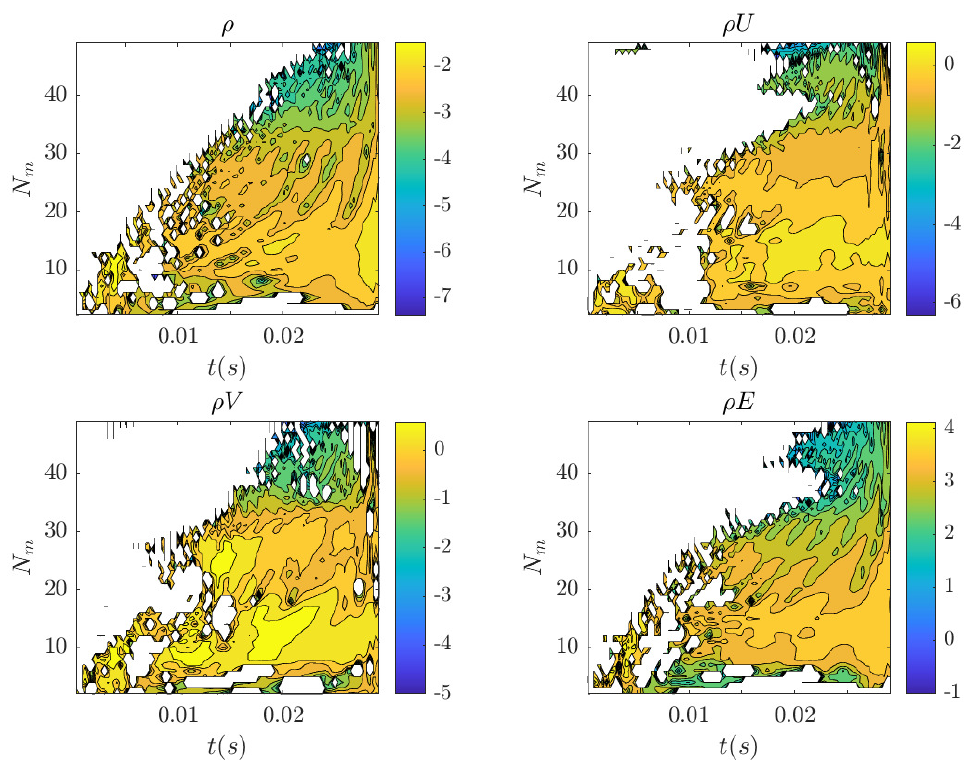
Figure 9. The log 10 ( (cid:101) diff ) considering POD as the reference single ROM, versus the time and number of modes, 30P30N test case. White regions correspond to (cid:101) diff = 0, i.e., the residual based adaptive ROM selects